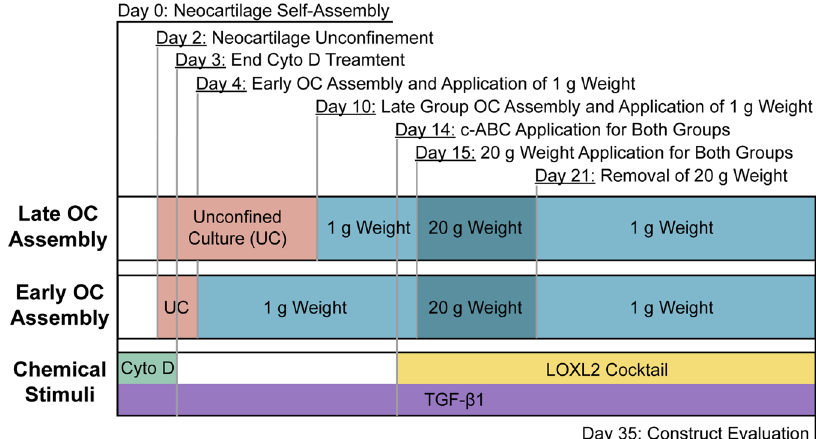
Fig. 9 Culture and treatment timeline. OC osteochondral, Cyto D cytochalasin D, c-ABC chondroitinase-ABC, LOXL2 lysyl oxidase-like 2